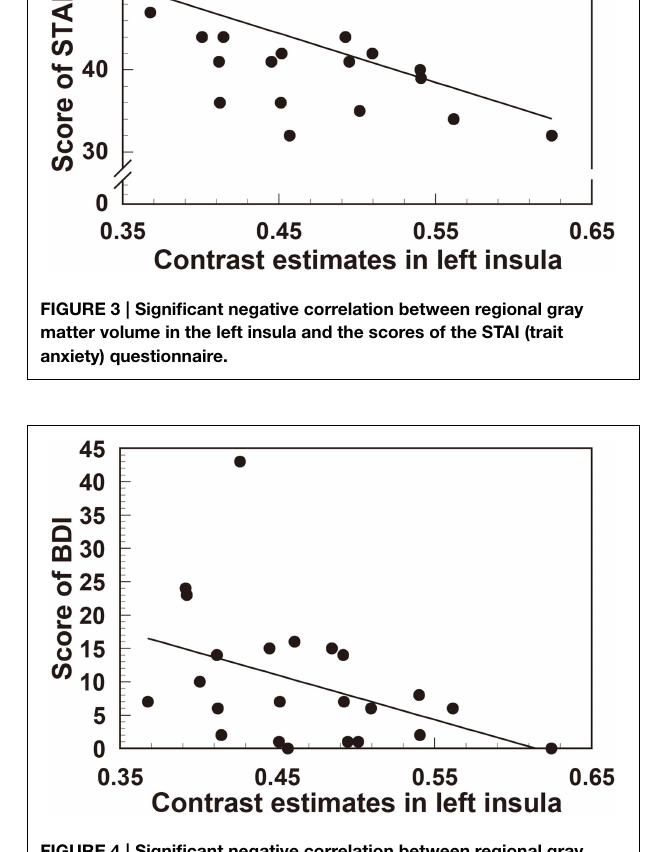
FIGURE 4 | Significant negative correlation between regional gray matter volume in the left insula and the scores of the BDI (depression)